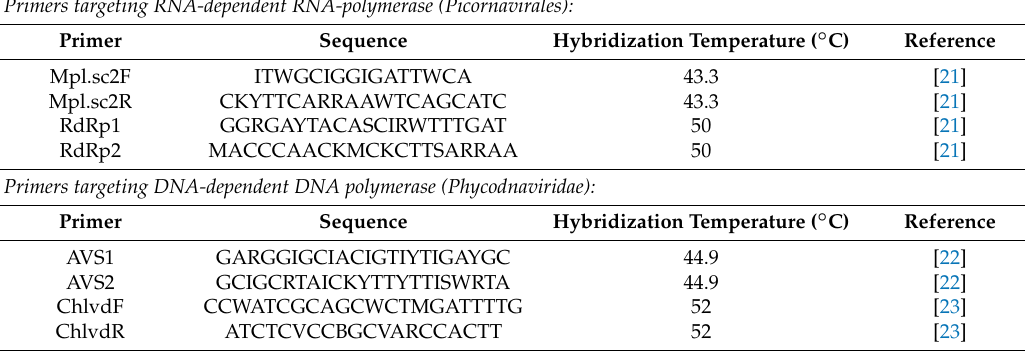
Table 1. Primers used in this